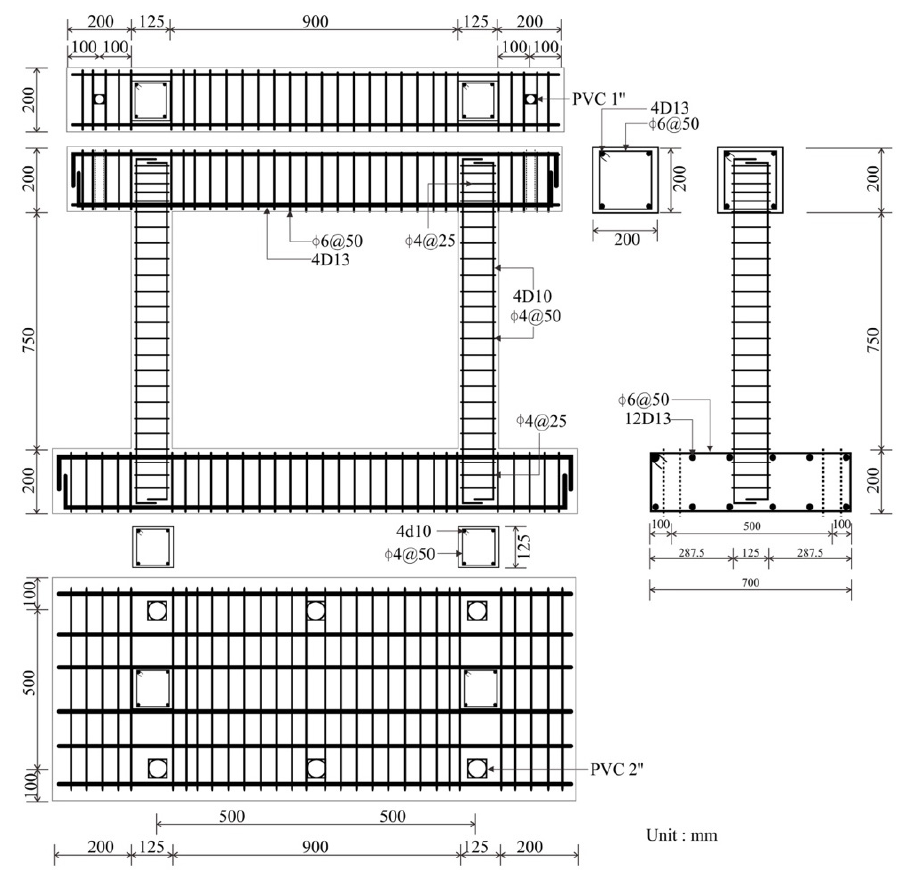
Figure 1. Geometric and reinforcement detail of the RC frame specimen.